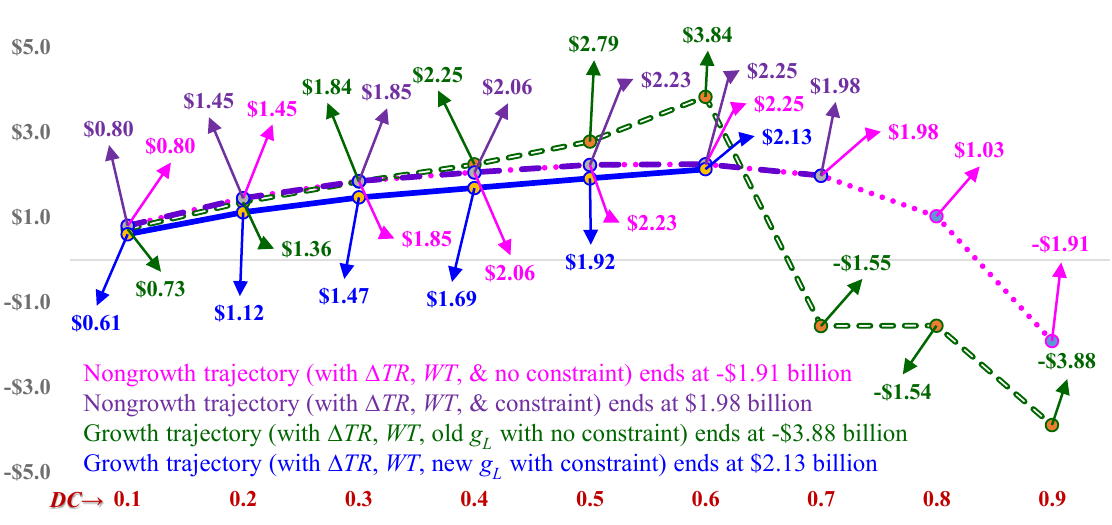
G versus Debt Choice: Old g L